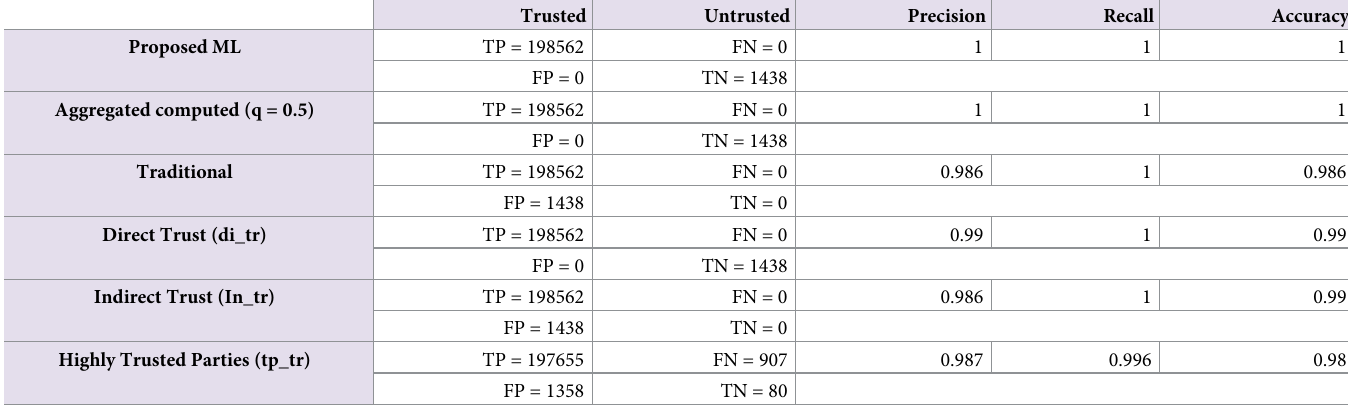
Table 2. Confusion matrix of the proposed models applied on Brightkite